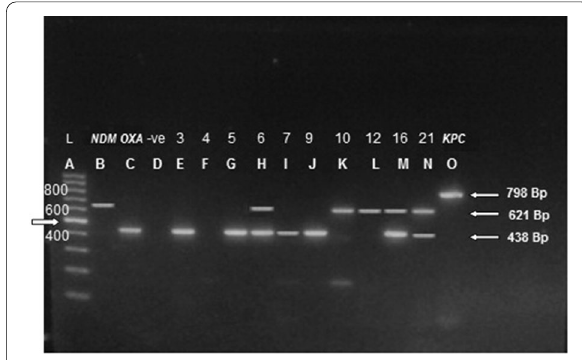
Fig. 1 Multiplex PCR results on agarose gel electrophoresis for bla NDM , bla OXA and bla KPC . A 100 bp DNA ladder. B , C and O: E. coli isolates used as positive controls for bla NDM‑like (621 bp), bla OXA‑48‑like (438 bp) and bla KPC‑like (798 bp), respectively. D Negative control. E , G , I and J Isolates positive to bla OXA‑48‑like . K and L Isolates positive to bla NDM‑like . H , M and N Isolates positive to both bla NDM‑like and bla